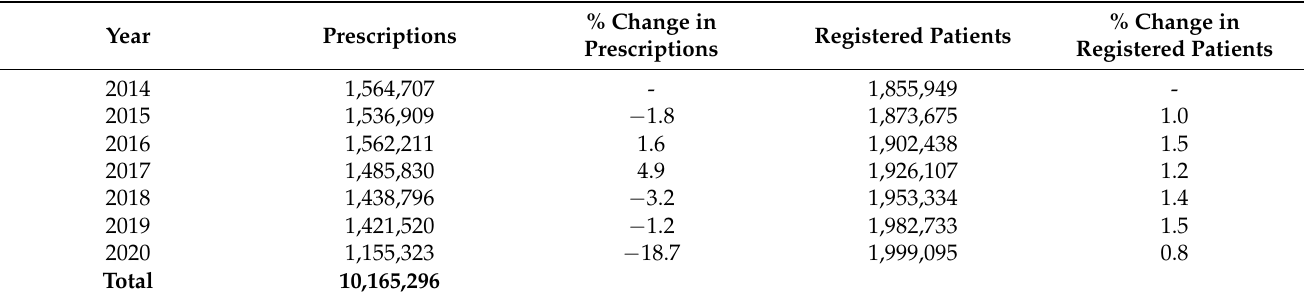
Table 1. Total prescriptions and the number of patients registered with a GP, with year-on-year percentage